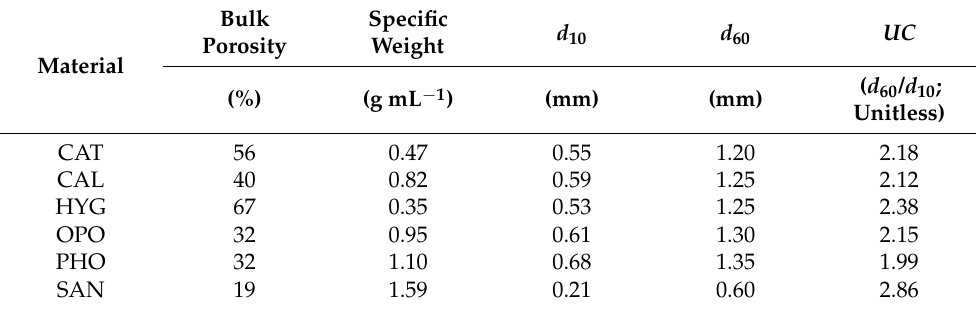
Table 3. Physical characteristics of the six non-coated materials. Bulk porosity, specific weight, mess diameter allowing 10% and 60% of the material to pass through and uniformity coefficient ( n = 2 for particle analysis, n = 3 for bulk porosity and specific